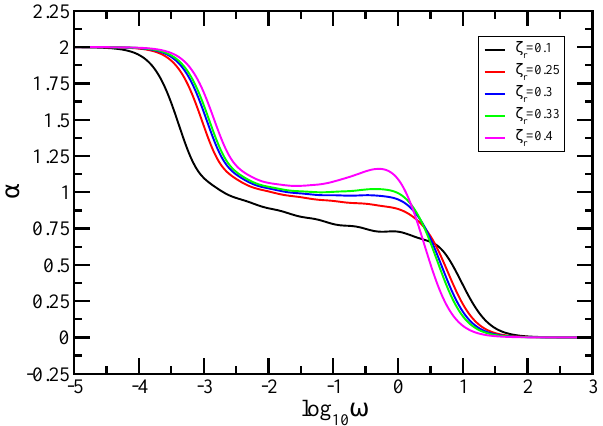
Figure 10. Local slopes α of the curves of Figure 9. The inset gives the considered values of the hydrodynamic interaction strength. Zimm